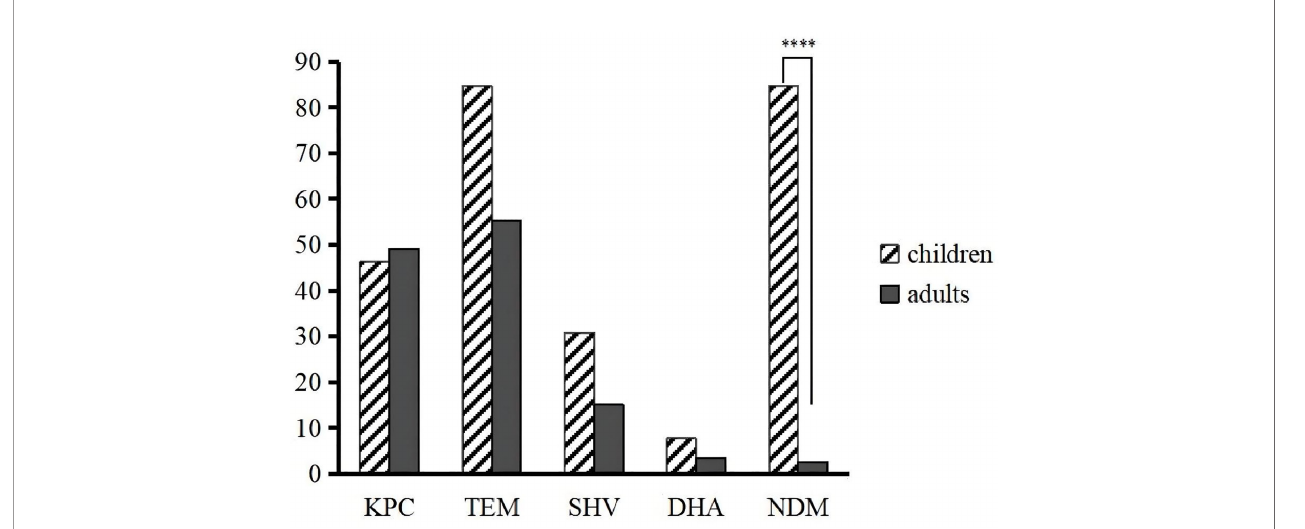
FIGURE 3 | Differences in the prevalence of resistance genes between children and adults. ****p < 0.0001.